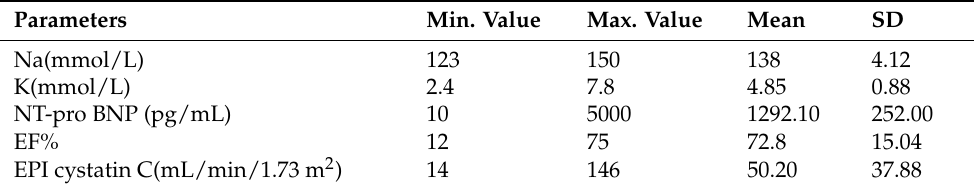
Table 2. Glomerular filtration and functional status of the subjects’